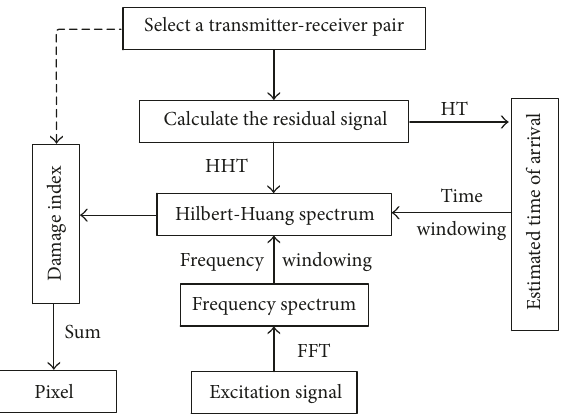
Figure 7: Procedure of damage